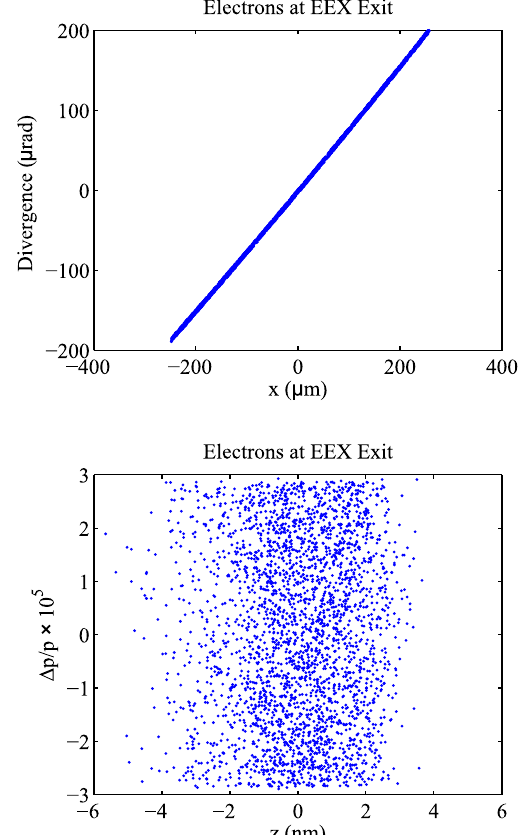
FIG. 6. The phase space of the output electron bunch in the (top) transverse and (bottom) longitudinal dimension.